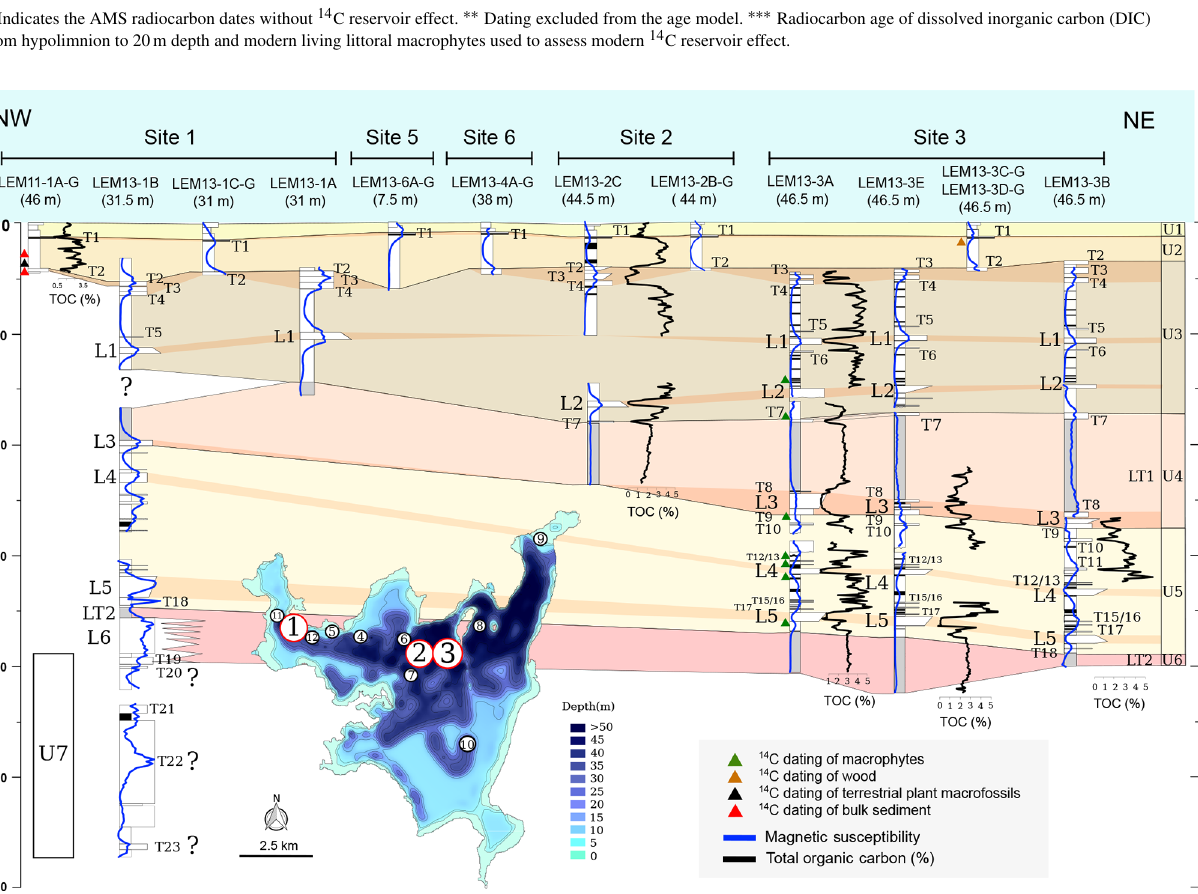
Figure 3. West–east LdM core correlation in the northern areas based on lithostratigraphic and sedimentological criteria. White circles indicate coring site. Magnetic susceptibility (MS; × 10 − 8(m 3 kg − 1 )), total organic carbon (TOC, %) and the occurrence of tephra layers. The stratigraphic units are marked in different colors: unit 1 – yellow; unit 2 – light brown; unit 3 – brown; unit 4 (LT1) – light red; unit 5 – light yellow; and unit 6 (LT2) –